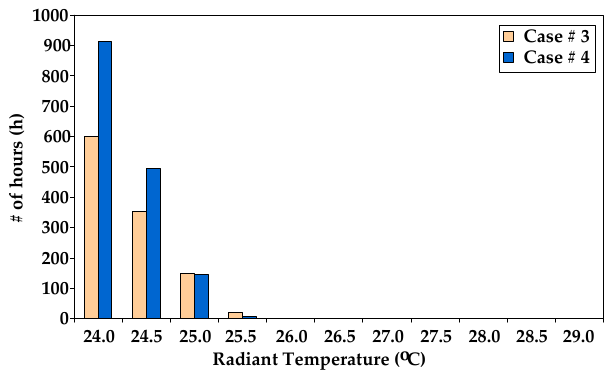
Figure 8. Radiant temperature distribution within the corridor area at level 13, with chilled ceilings and with the internal shading element (Case # 4).